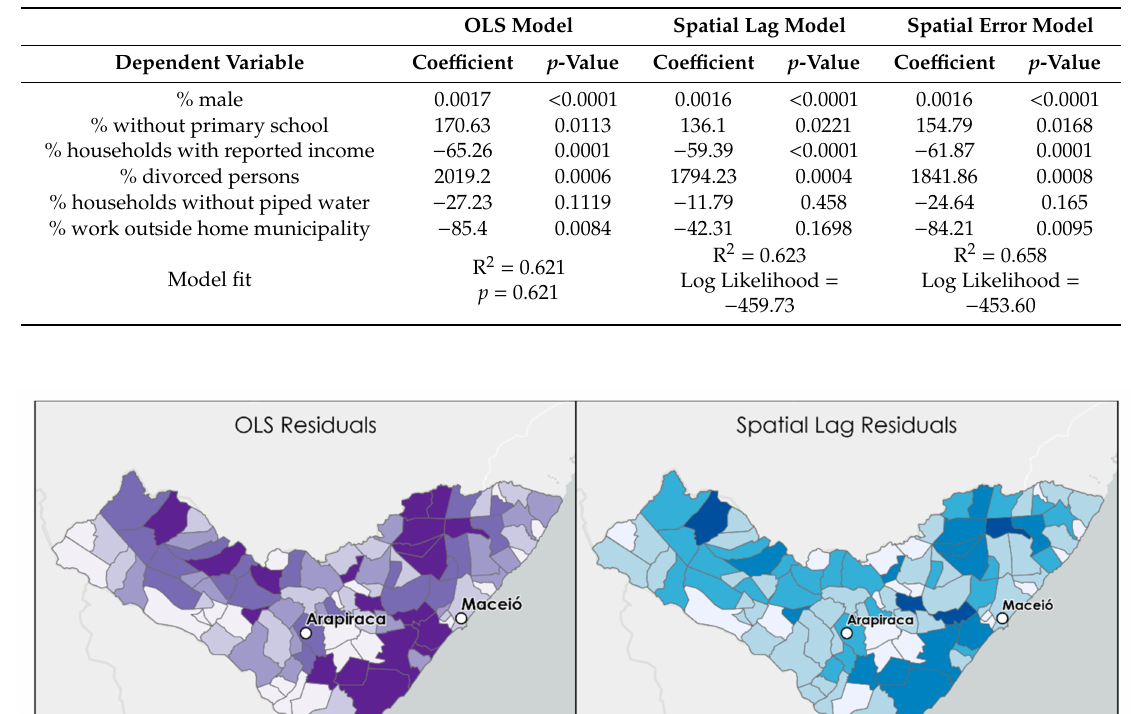
Table 2. Multivariable regression results indicating significant correlations between the selected socioeconomic indicators and homicide rates.